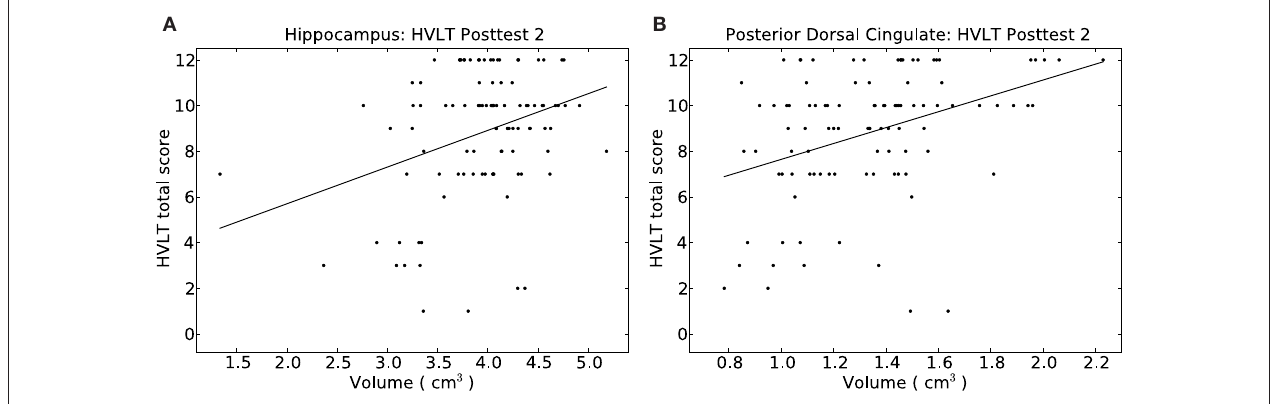
FIgure 3 | Depiction of the relationship between HvLT delayed correct recall score at posttest 2 versus the volume of (A) the hippocampus, and (B) the posterior dorsal cingulate gyrus. Simple least-squares lines are plotted; detailed regression results appear in Tables 4 and 5.